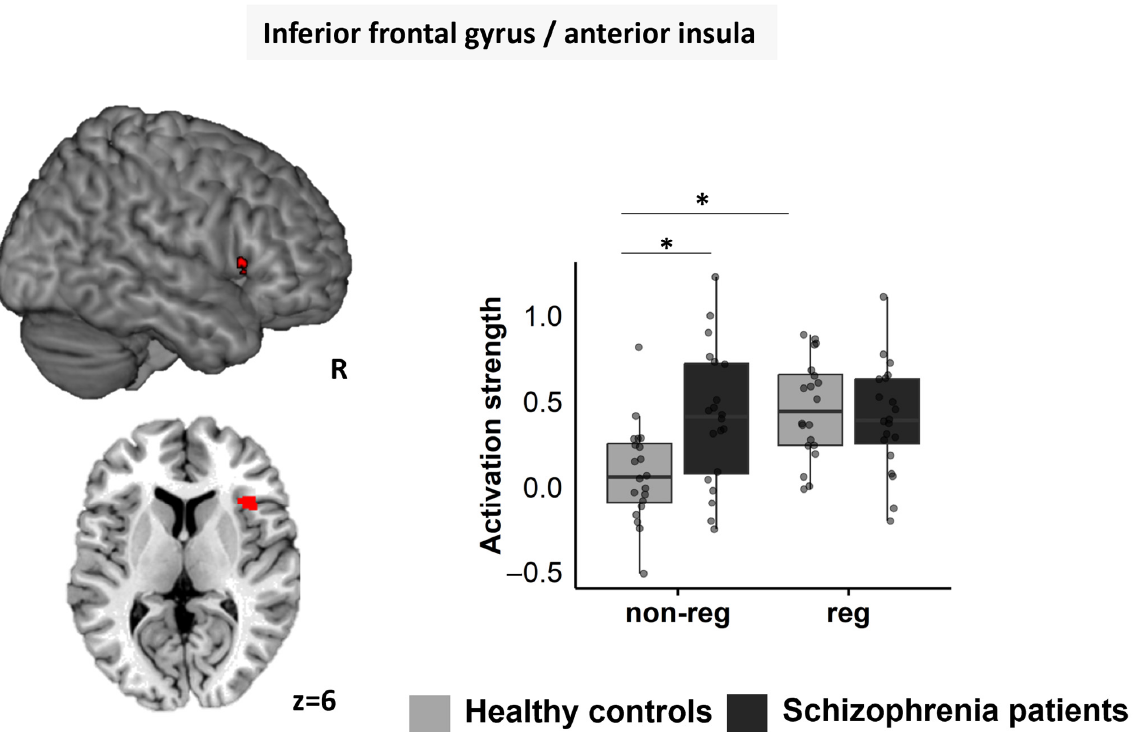
Figure 5. Region-of-interest-analysis of the right IFG/aI (red) showed a “regulation-by-group” interaction. SZP showed higher activation than HC within the non-regulation block. For HC, higher activation was seen in the regulation block compared to the non-regulation block. non-reg = non-regulation block; reg = regulation block; R = right. Significant differences are marked with *.